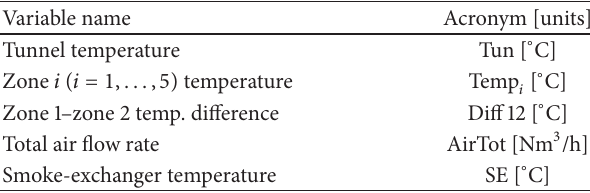
Table 3: The main Controlled